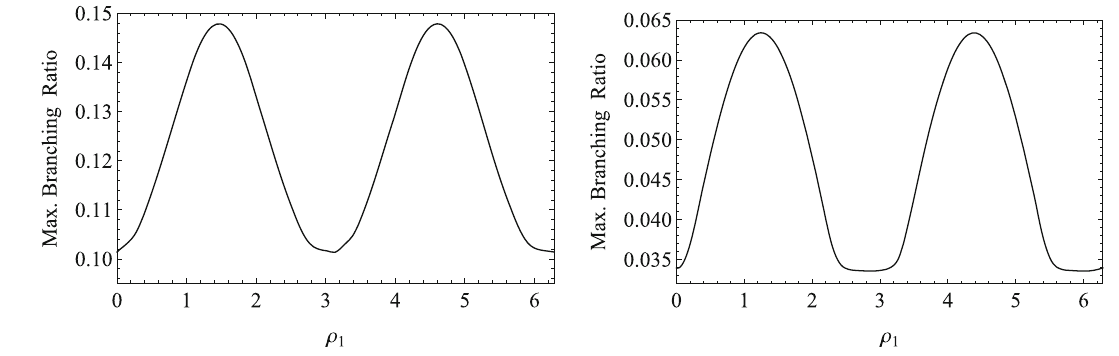
obtained after performing a parameter scan for rest of the free parame- (cid:6) 2 ( N i → i ters, X and Y . From the figure we read the maximum value to be 0 . 148 m N m i = 1 BR (0 . 0634) for the NH (IH) 1 for the NH (IH)